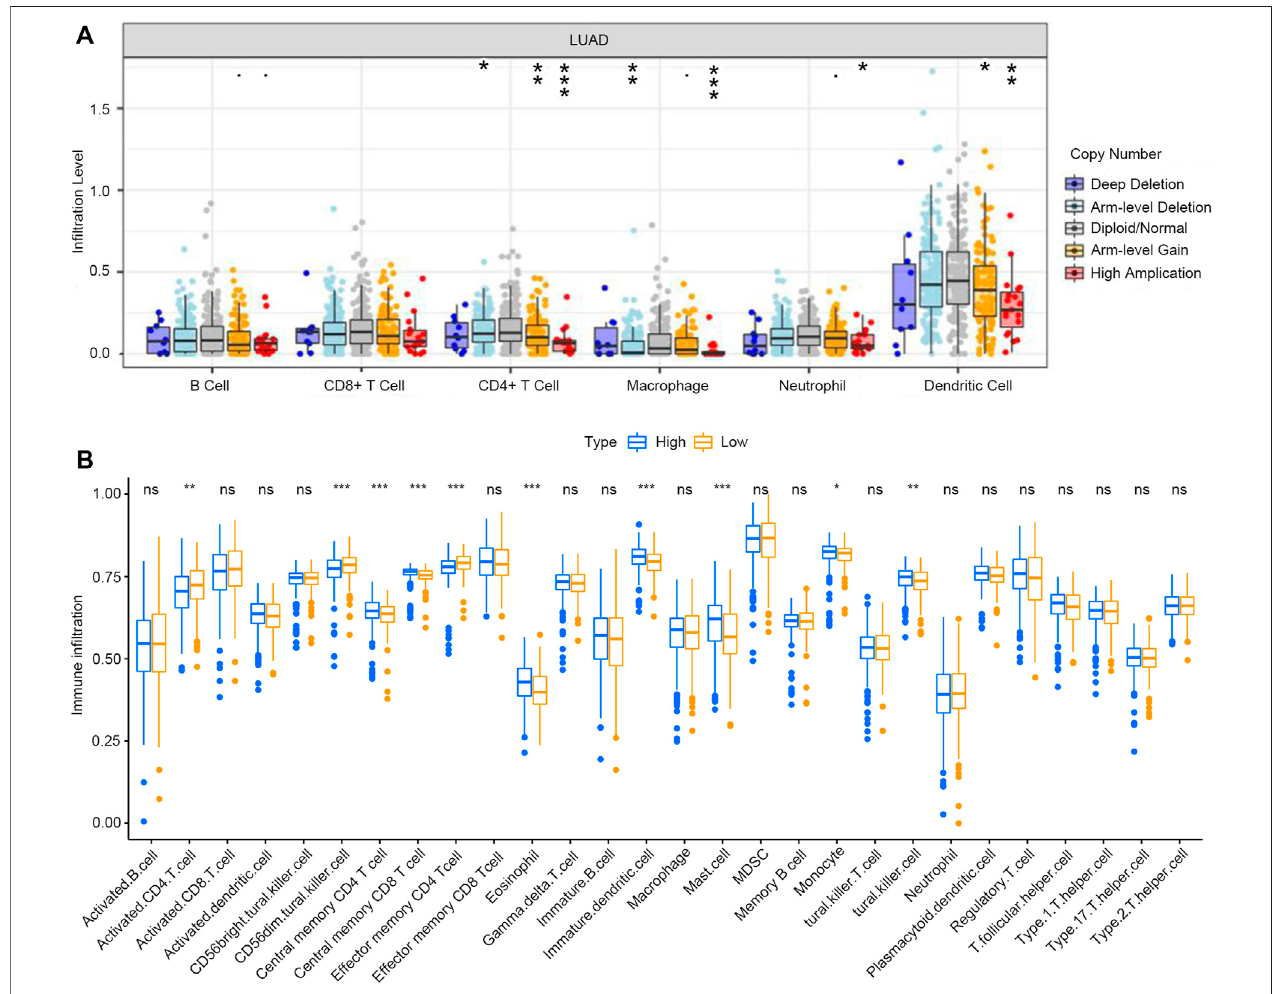
FIGURE 8 | Relationship between expression of RAB11FIP1 and level of immune invasion in LUAD (A) RAB11FIP1 copy number variation affected the in fi ltration level of CD8 + T cells, Macrophages, Neutrophils, and Dendritic cells in lung tissues. (B) The distribution of 28 subtypes of immune cells in low and high RAB11FIP1 expression